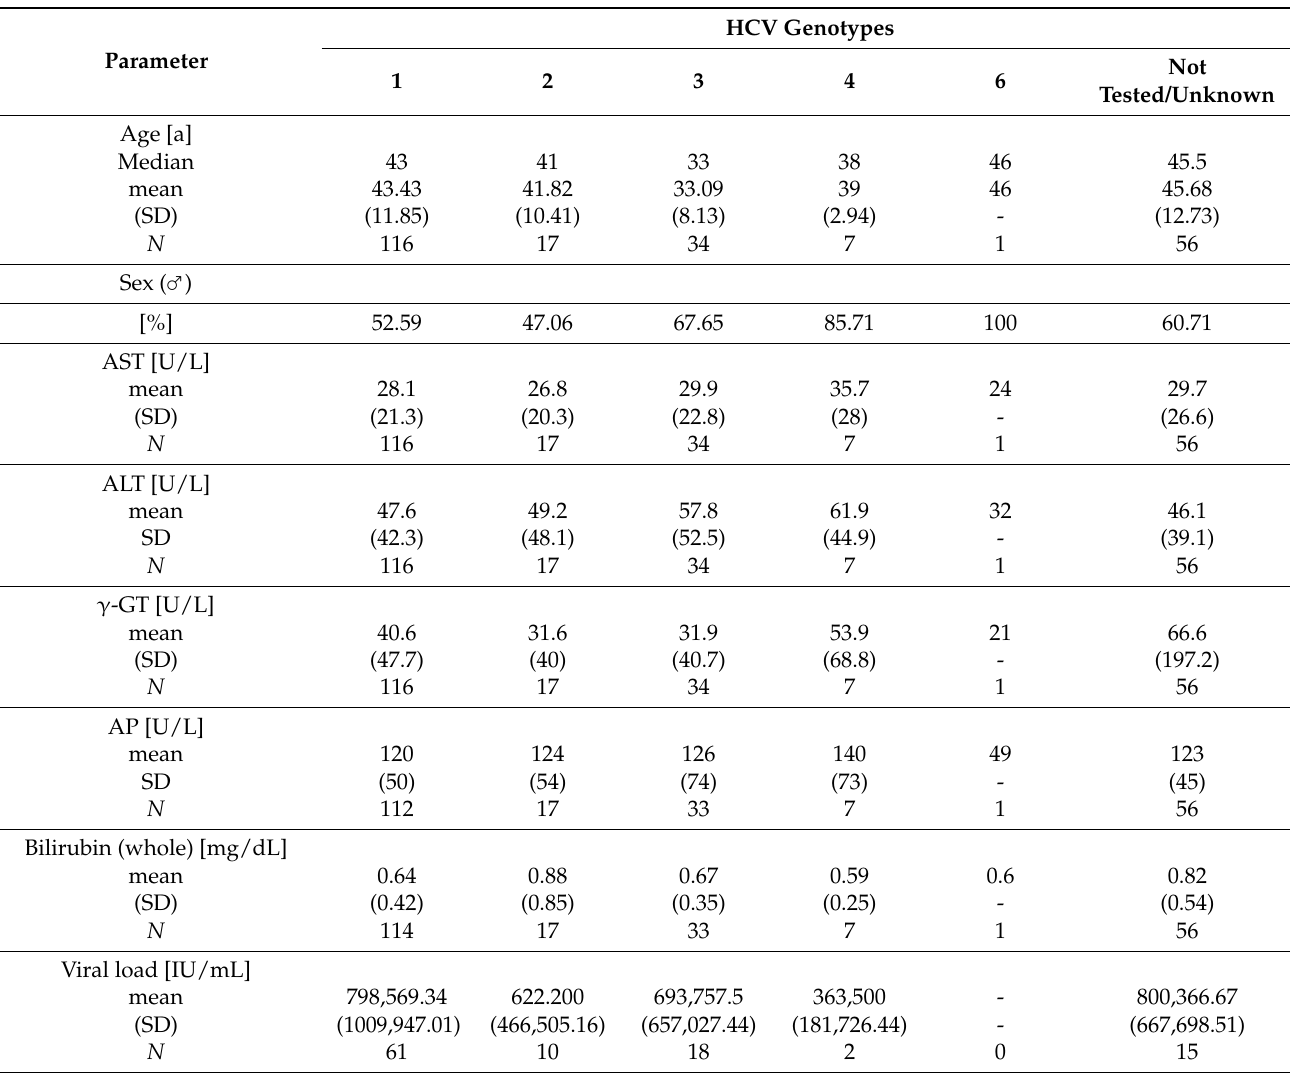
Table A1. Patient characteristics in different HCV genotypes.